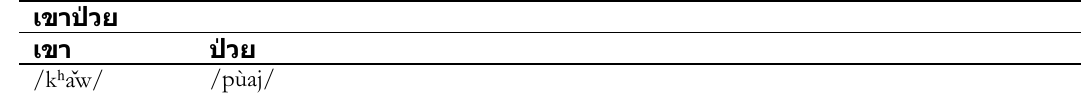
TABLE 1. Thai Simple